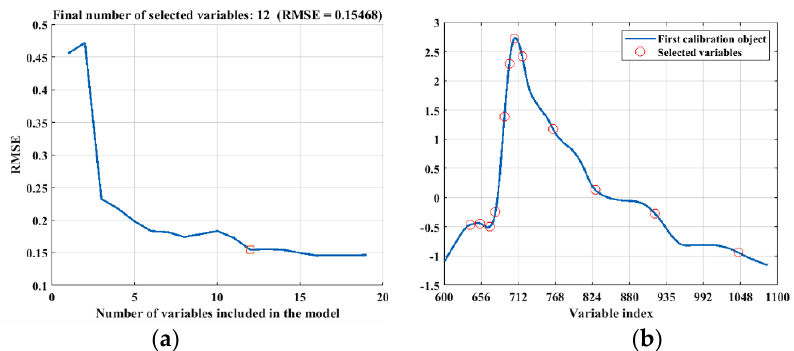
Figure 9. ( a ) Final number of selected variables; ( b ) the position distribution of the variables selected by SPA using the spectrum data. Table 4. Prediction results of SVM model based on SPA feature wavelength extraction (S – G+Nor-